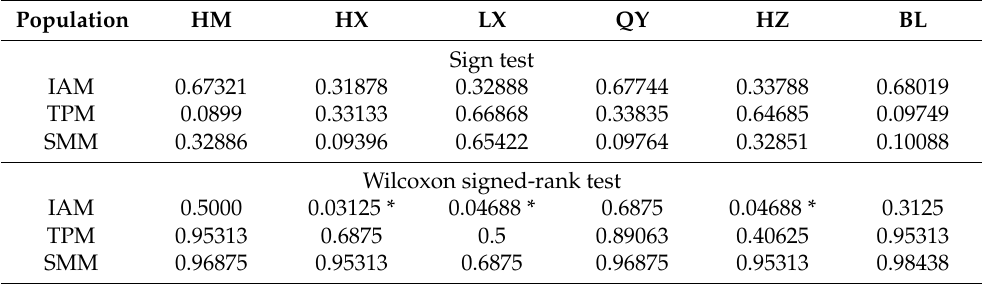
Figure 6. Results of the Bayesian clustering analysis performed in STRUCTURE based on microsatel- lite loci for 6 populations using an admixture model, assuming K from 2 to 6 (the optimal Delta K = 3). The genetic clusters are coded by distinct colors. Each vertical line represents one individual and implies the probability of membership to a genetic cluster. ( a ) plot of L(K) values from structure analysis, ( b ) plot of delta K values from structure analysis, and ( c ) bar plot from structure clustering analysis with K = 3. Table 5. Bottleneck analysis for Coilia grayii populations using Sign test and Wilcoxon rank test (Probability for one-tail test, heterozygosity excess) under infinite allele, stepwise mutation, and two-phase model. Parameters for TPM: variance = 10%, proportion of SMM = 90%, estimation based on 1000